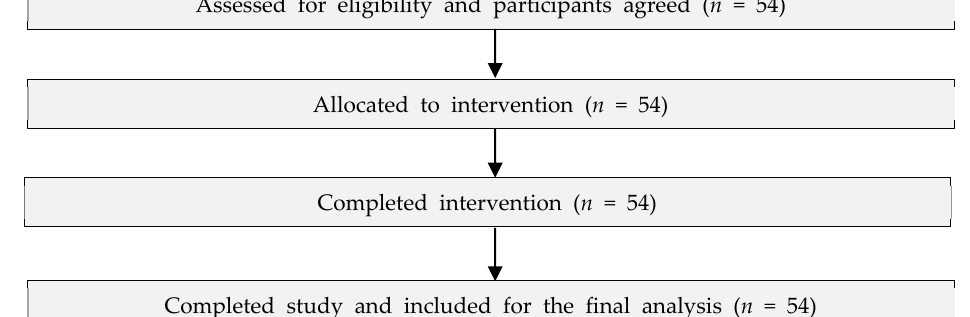
Figure 1. The sampling procedure.